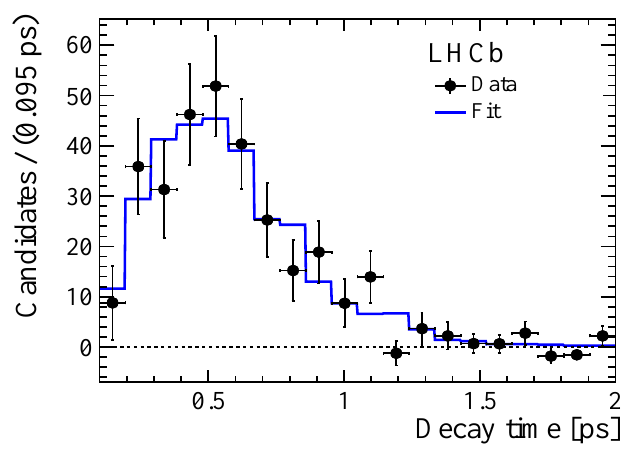
Figure 5. Ξ ++ decay distribution and fit result cc